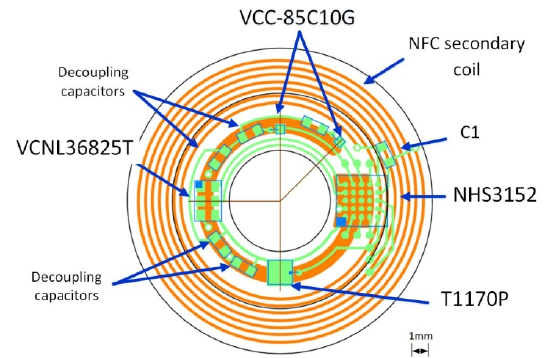
Figure 10. Implementation of the three functions of the block diagram of Figure 9 (VCC-85C10G: VCSEL; T1170P: photodiode; VCNL36825: proximity sensor as refractometer; NHS3152: smart sensor IC). Table 1. Multimodal SCL parts’ description.